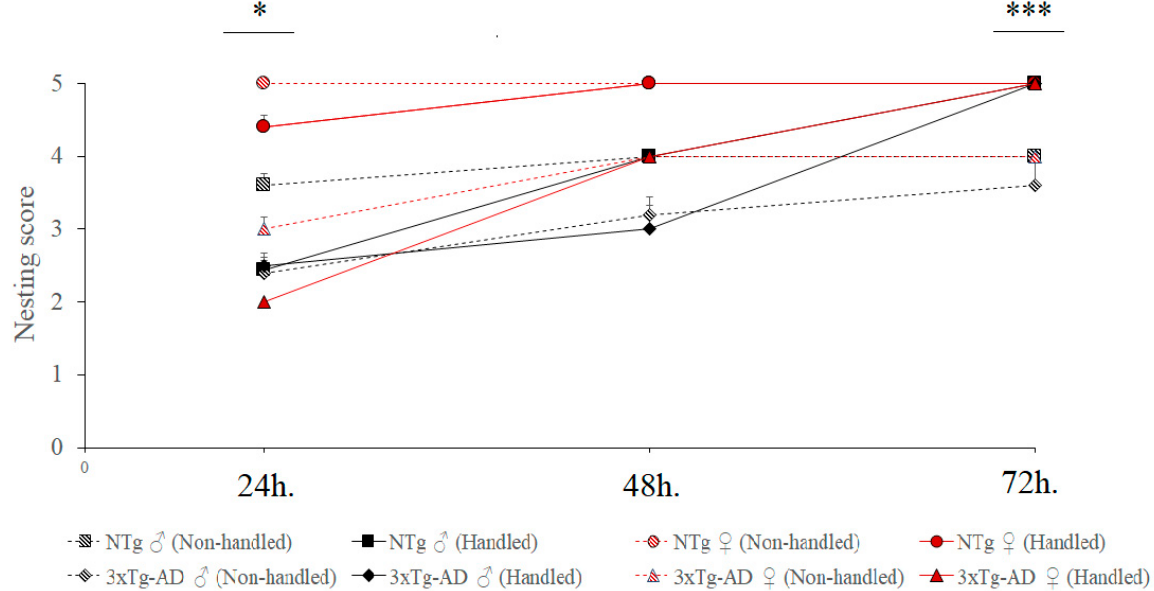
Figure 2. Nesting scores in social structures of male and female six-month-old non-transgenic (NTg) and 3xTg-AD mice using cotton material, and long-term effects of early postnatal handling. Results are expressed as mean ± SEM. N = 9–11 per group: Non-handled, male social structure; Handled, male social structure; Non-handled, female social structure; handled, female social structure. Mann–Whitney U test for comparisons, * p < 0.05 and *** p < 0.001 vs. NTg mice of the same sex . Table 1. Long-term effects of early postnatal handling on home-cage-based social nests built by male and female six-month-old NTg and 3xTg-AD mice.